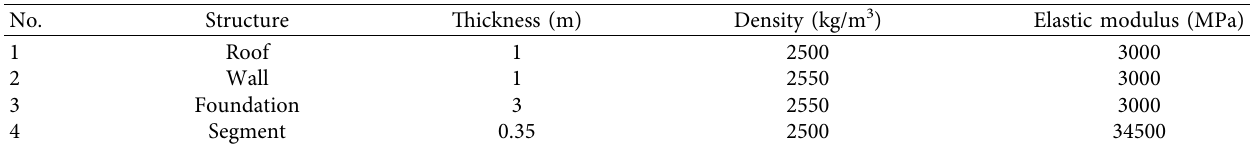
Table 3: Mechanical parameters of underground structure.